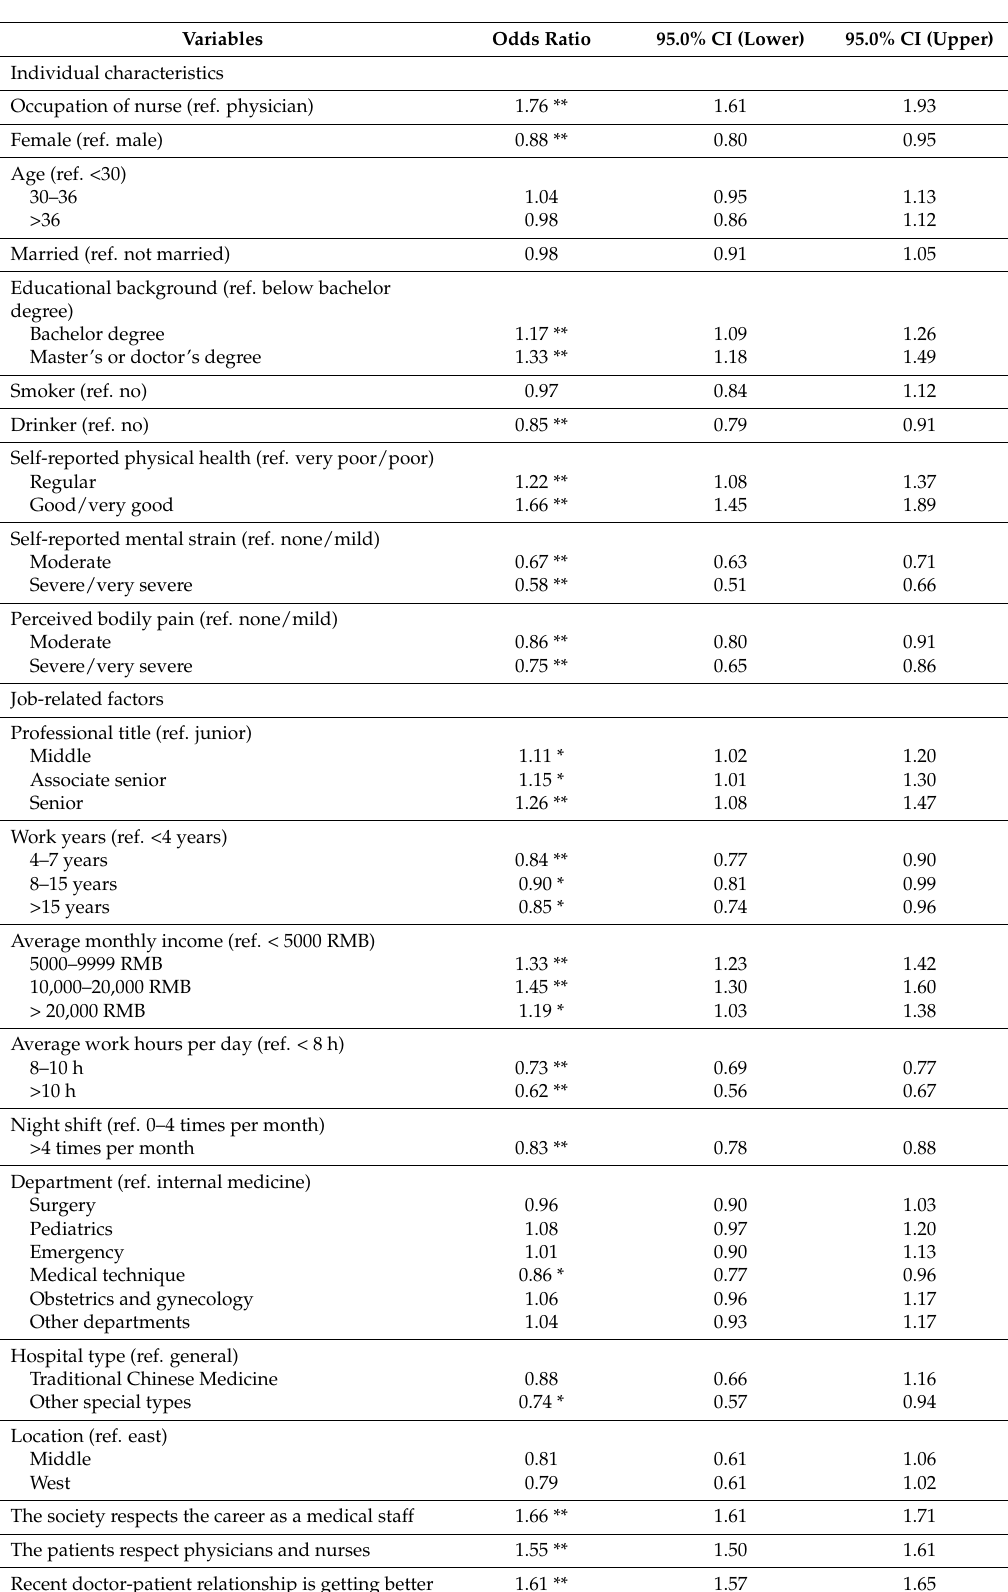
Table 5. Logistic regression examining individual characteristics and job-related factors associated with job satisfaction (satisfied versus